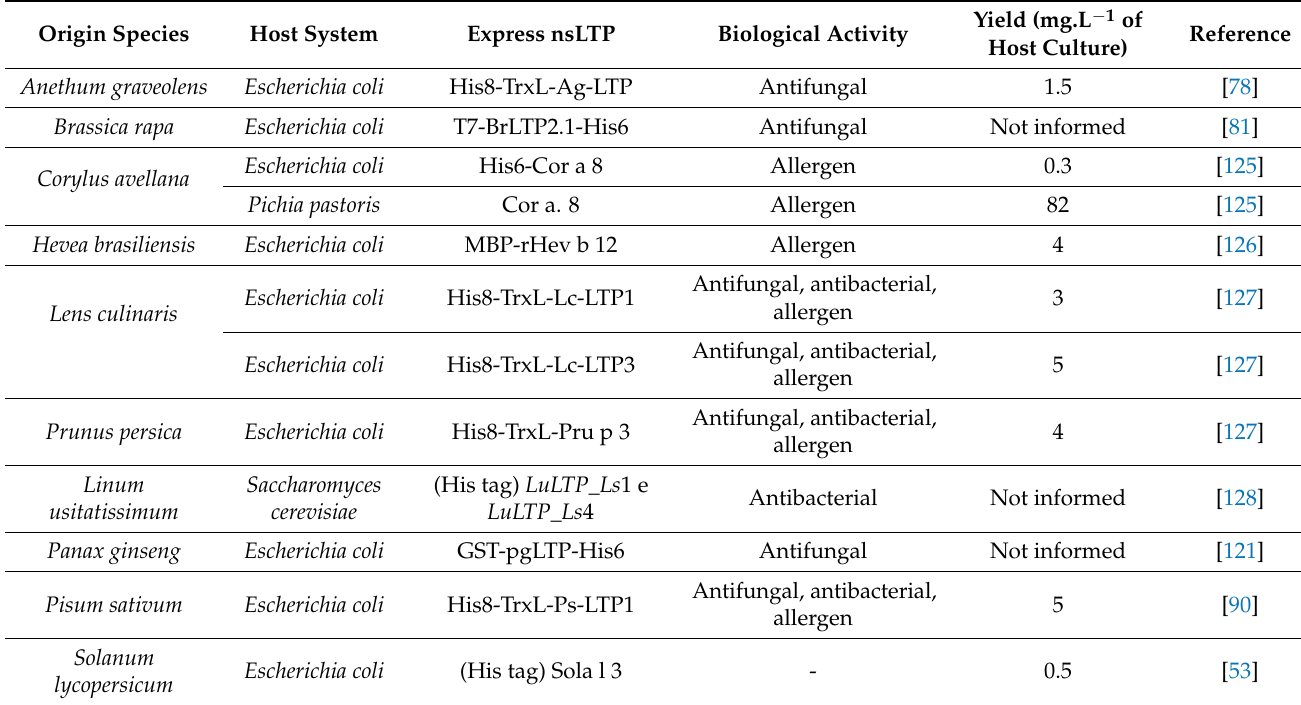
Table 3. Recombinant LTPs produced by different heterologous expression systems, including tested biological activity and final post-purification